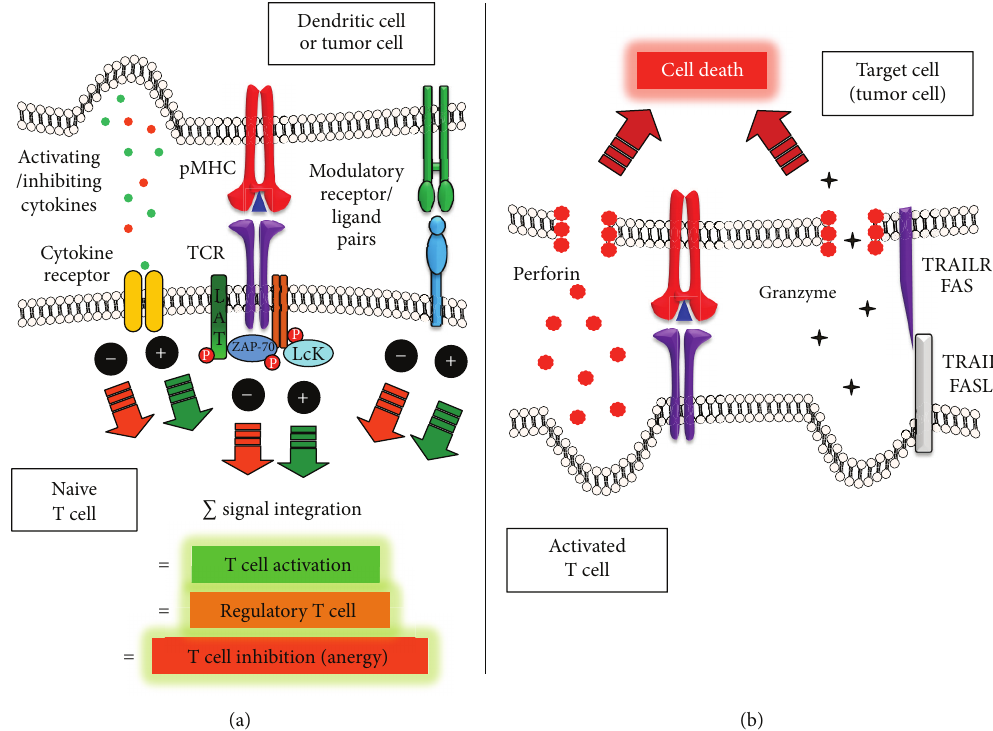
Figure 2: Activating and inhibiting immunological synapses for na¨ıve and effector T cells. (a) APCs bear modulatory molecules on their surfaces that shape T cell activation and differentiation during IS assembly. Costimulatory molecules provide positive stimuli to T cells that are activating, while inhibitory molecules dampen T cell activation producing anergic or regulatory T cells. Tumor cells have been shown to express T cell inhibitory molecules on their surface to abrogate T cell activation or modulate their activity to produce inhibitory regulatory T cells. Cytokines and chemokines expressed by APCs or tumor cells can also modulate T cell activation synergizing or antagonizing with the above-mentioned membrane-bound molecules. Concentration of TCR/pMHC and adhesion molecules at the APC-T cell interface forms an immunological synapse. (b) CTLs exert their cytotoxic effects mainly through the release of soluble cell-killing molecules released towards target cells. Cytotoxic molecules include granule proteases known as granzymes aided by membrane-disruptive proteins known as perforins. Additionally, engagement of death receptors on the target cells, such as Fas (CD95) and TRAILR by FasL (CD95-ligand) and TRAIL molecules expressed on the surface of T cells, can also induce cell death mediated by